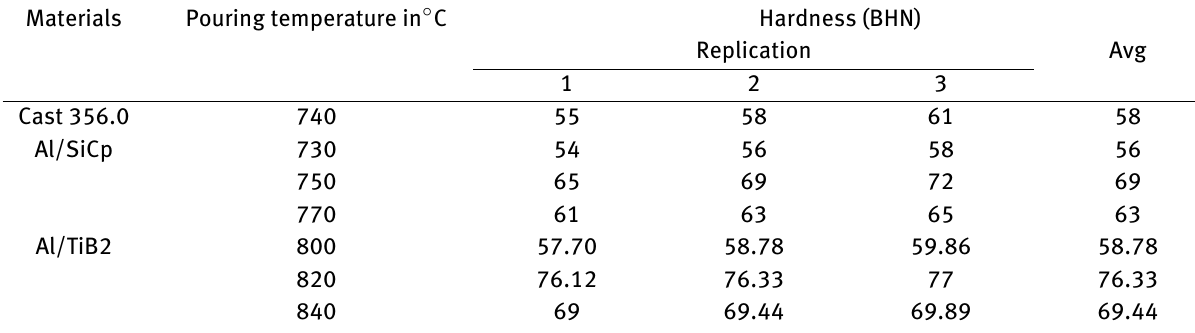
Table 4: Hardness of Al/SiCp and Al/TiB 2 MMCs Materials Pouring temperature in ∘ C